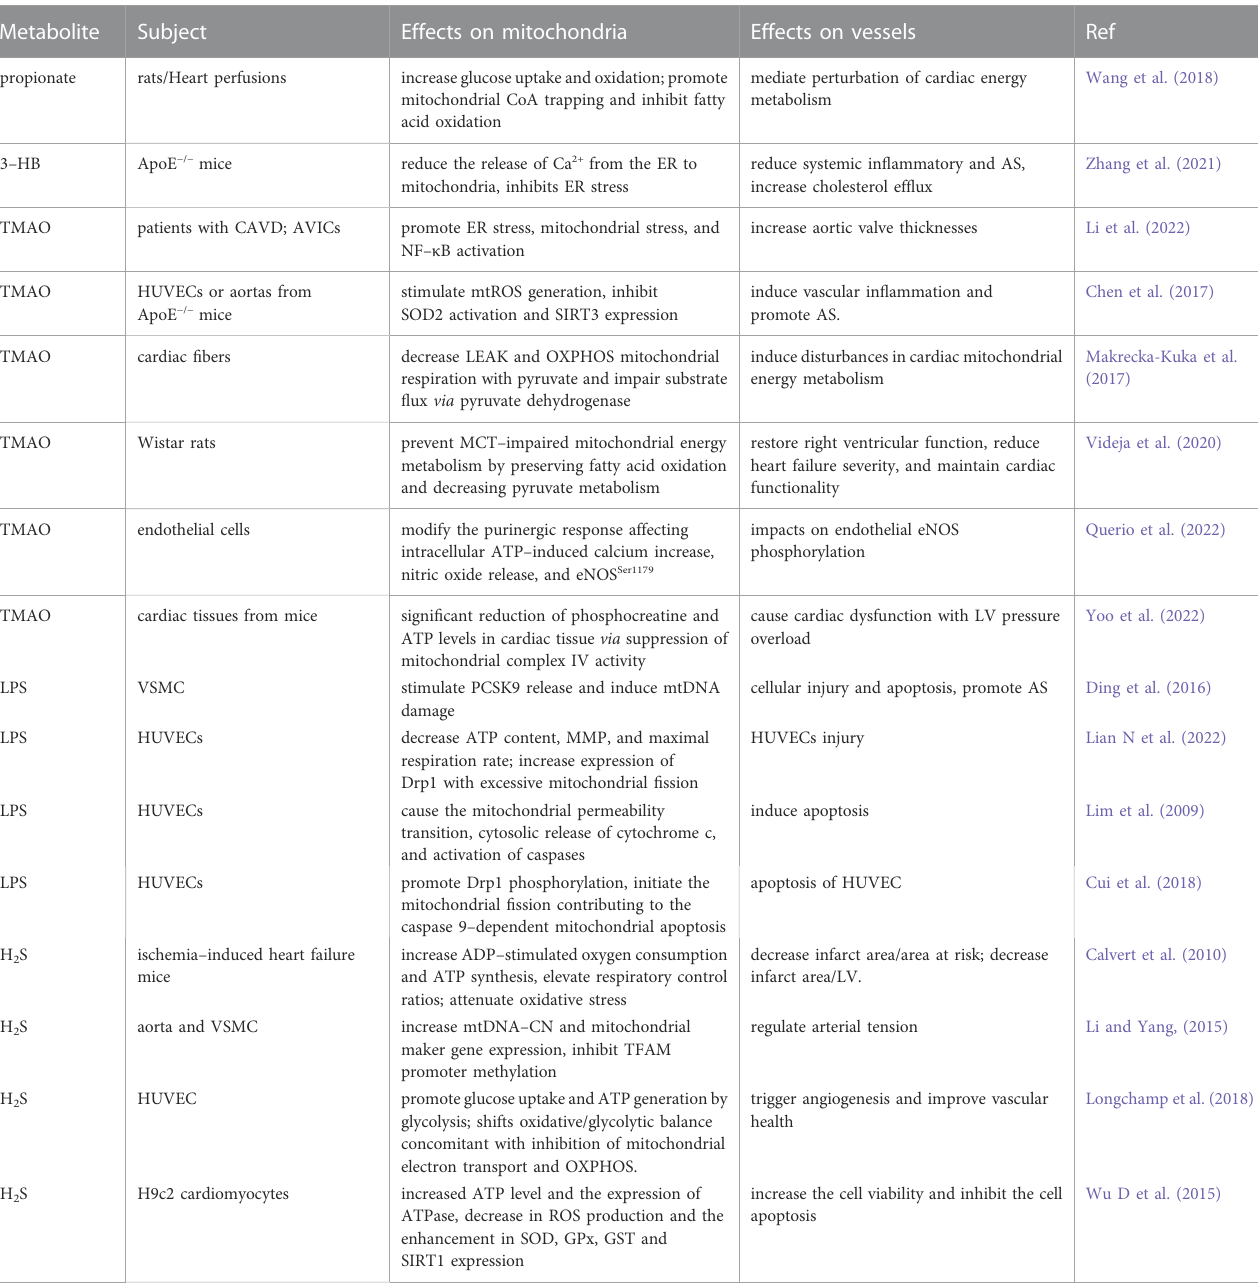
TABLE 1 Effects of intestinal microbiota metabolites on mitochondria and